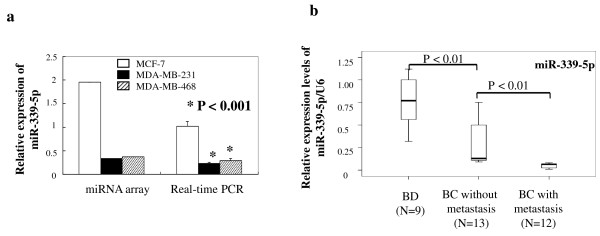
Expression of miR-339-5p in breast cancer cells and tissues. A. miRNA microarray and real-time PCR analysis of miR-339-5p expression. MDA-MB-231 and MCF-7 cells were grown in monolayer for 5 days, and total RNA was extracted from the cells and subjected to microarray and real-time PCR analyses. B. Real-time PCR analysis of miR-339-5p expression. Fresh tissue samples from breast cancer patients with or without lymph node metastasis and from patients with benign breast diseases were obtained from the surgery room. Total RNA was extracted from the tissues and subjected to real-time PCR analysis.